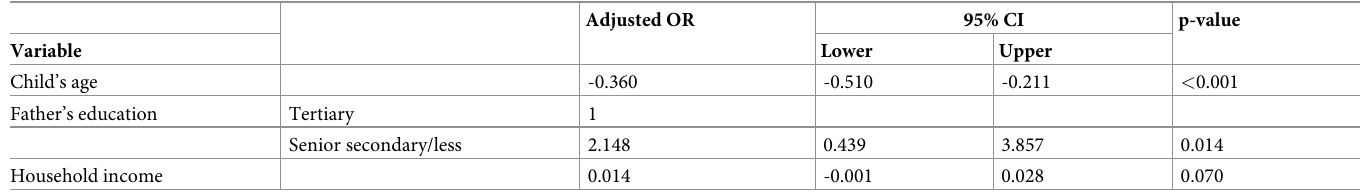
Factors that are associated with anemia knowledge scores were analyzed with univariate and multivariate linear regression. In the univariate analysis, mother’s and father’s education, mother’s employment, and household income were significant predictors as shown in S2 Table in S1 File. All variables with a p-value of � 0.25 were considered for inclusion in the mul- tivariate model (mother’s and father’s education, household income, employment of the mother, and extended family or not). Father’s education, mother’s employment, and extended family did not significantly contribute to the model. The final model given in S3 Table in S1 File contained household income and mother’s education as significant predictors. Mothers with tertiary education had better anemia knowledge than mothers with lower educational achievements (collegiate and senior secondary or less). Table 5. Multivariate analysis of factors affecting